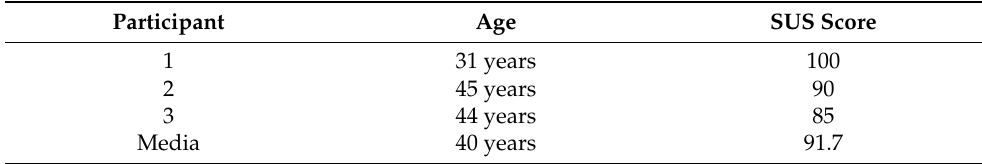
Table 4. Results obtained in system usability scale per participant.